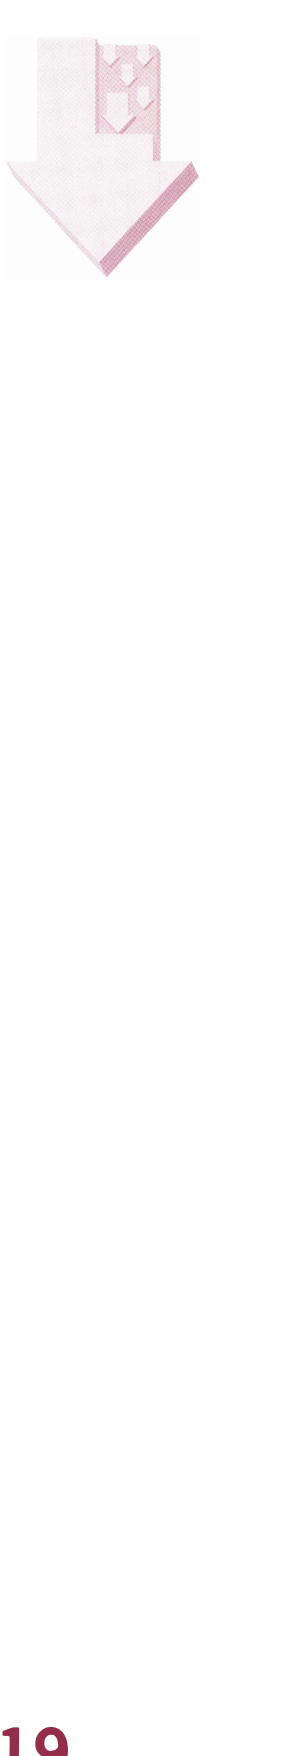
Fig. 5: Dependence of the viscosity ratio llVllD on the shear stress �0· The shear rate ratio 1ol1o = 100